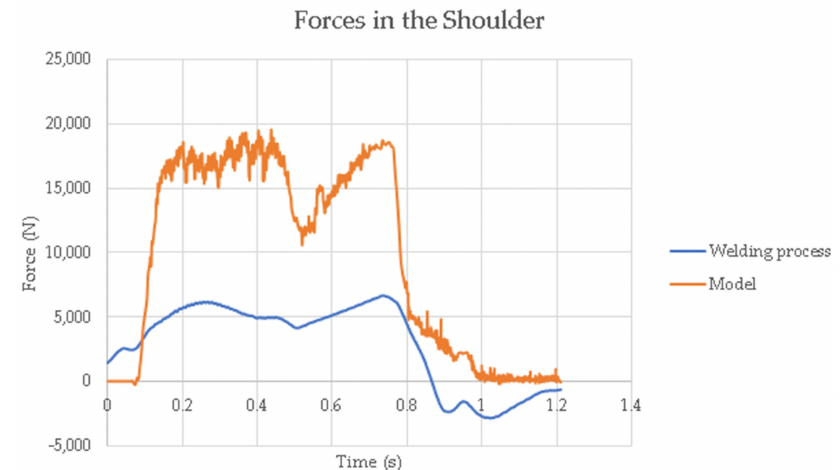
Figure 18. Comparison of forces on the shoulder during the RFFSW